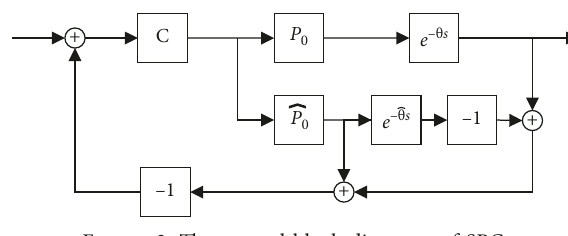
Figure 3: The control block diagrams of